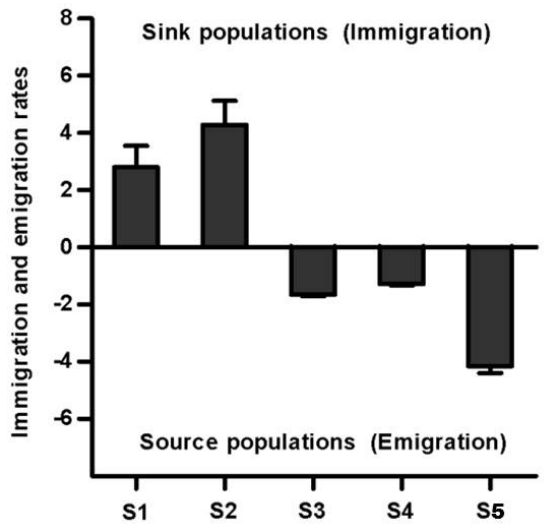
FIGURE 3 | Asymmetry in average proportions of immigrant and emigrant gene flow in five populations of Prochilodus lineatus from the Grande River basin. Bars show the mean difference between scaled immigration and emigration rate per population ± standard error. Positive values represent sink populations, with a relative excess of immigrants; and negative values represent source populations with a relative excess of